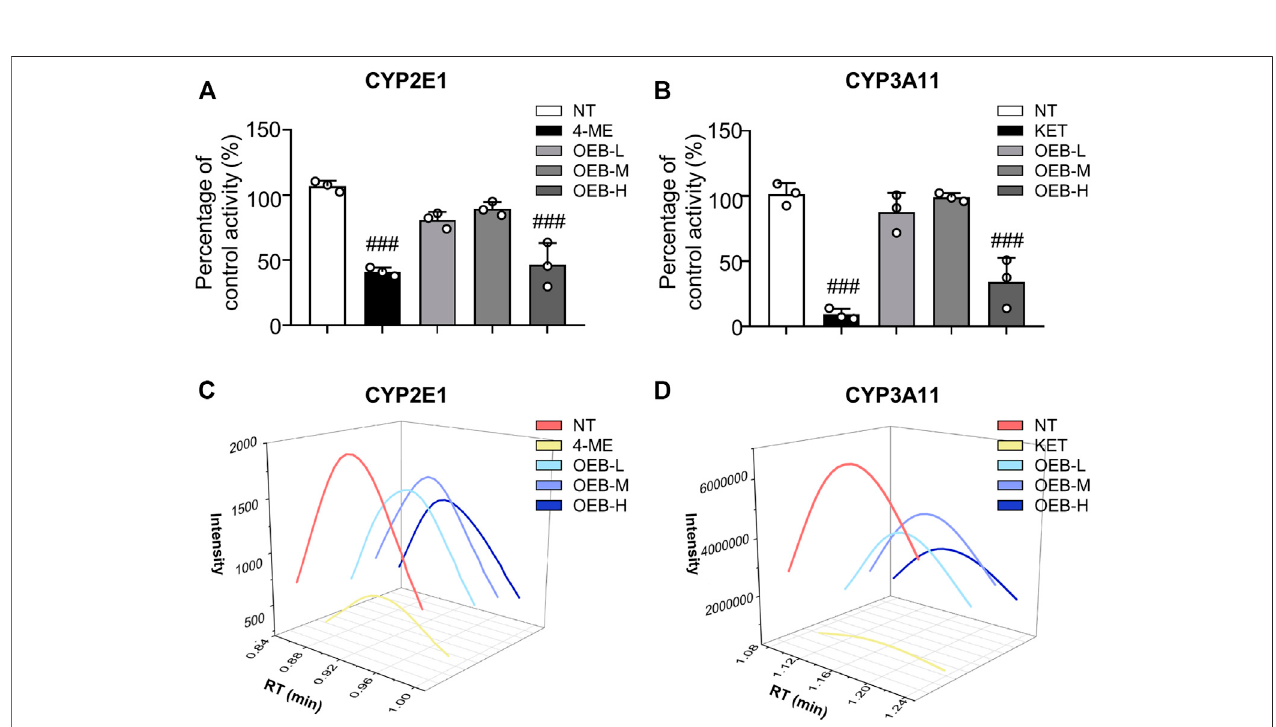
FIGURE 3| OEB reduced APAP-induced hepatotoxicity through regulating cytochromeP450 activity. Drug metabolizing enzymes (A) CYP2E1and (B) CYP3A11 activities were measured in hepatic microsomes by HPLC-MS/MS ( n = 3). Intensities of (C) CYP2E1 and (D) CYP3A11 were analyzed by HPLC-MS/MS. ### p < 0.001 versus NT